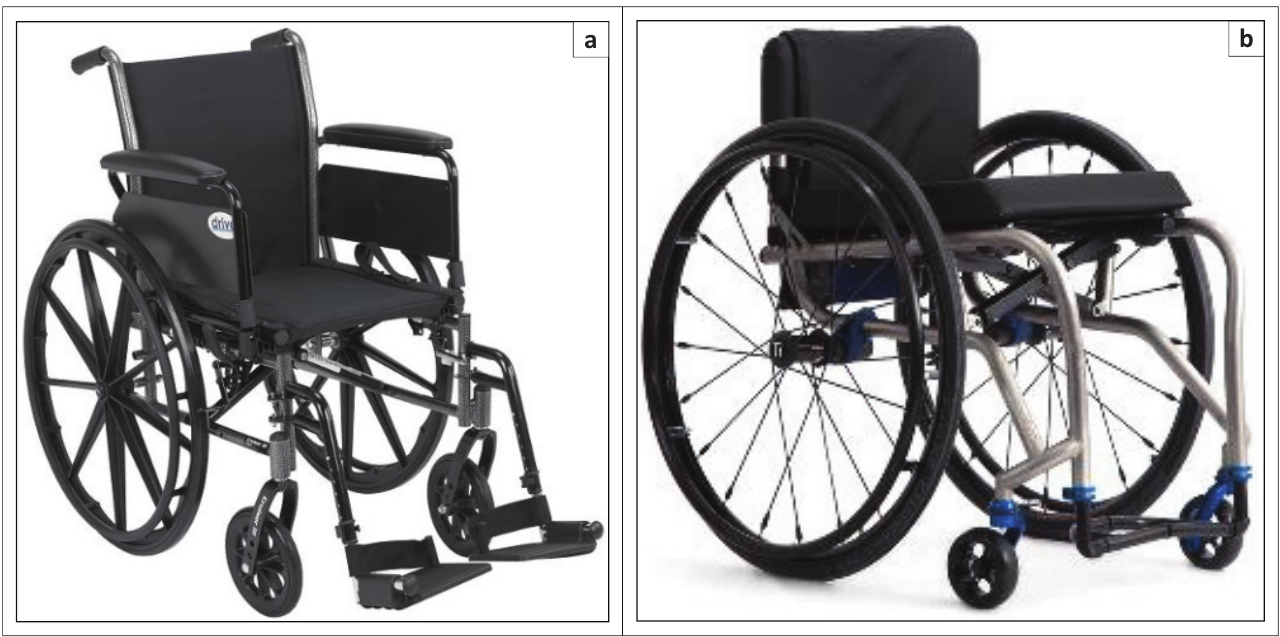
FIGURE 4: Lightweight wheelchair (left) and ultra-lightweight wheelchair (right).